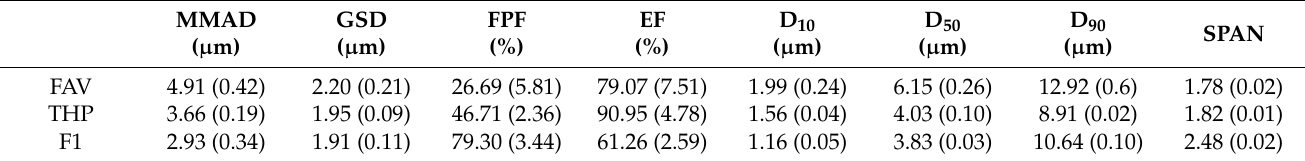
Table 5. Aerodynamic and volumetric size distribution of spray-dried pure FAV, pure THP, and optimized FAV-THP formulation (F1) under identical experimental conditions. N = 3 with standard deviations shown in brackets.